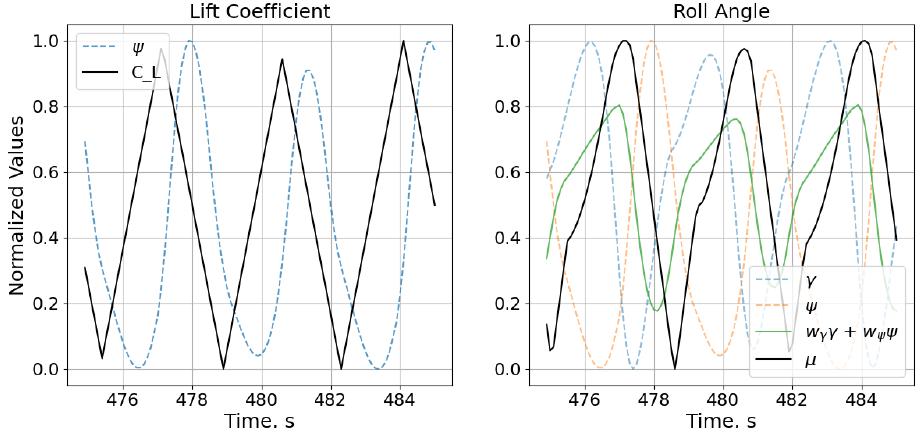
Figure 12. Network signal tracing of the dynamic soaring SUAV